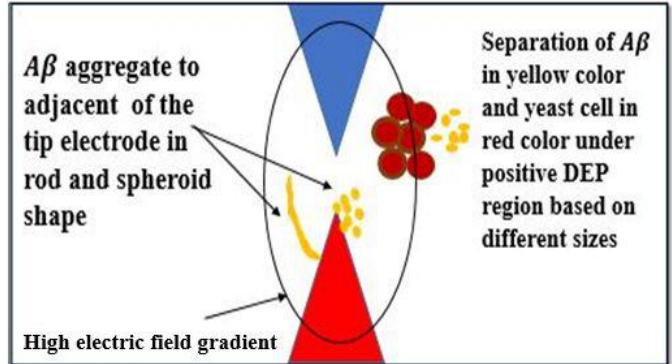
Figure 3. At 5 V pp 60 MHz the particles gradually start to accumulate and form a package of cells at the electrode, indicating positive DEP (pDEP) for Aβ and negative DEP (nDEP) for yeast cells.